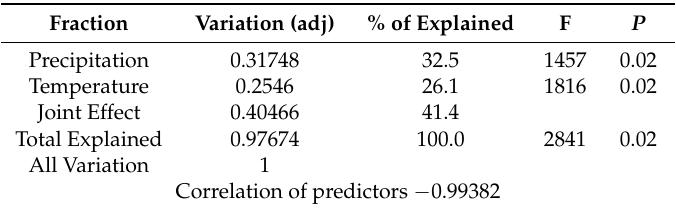
Table 5. Outcomes of RDA model(EMD) over the semiarid transect.